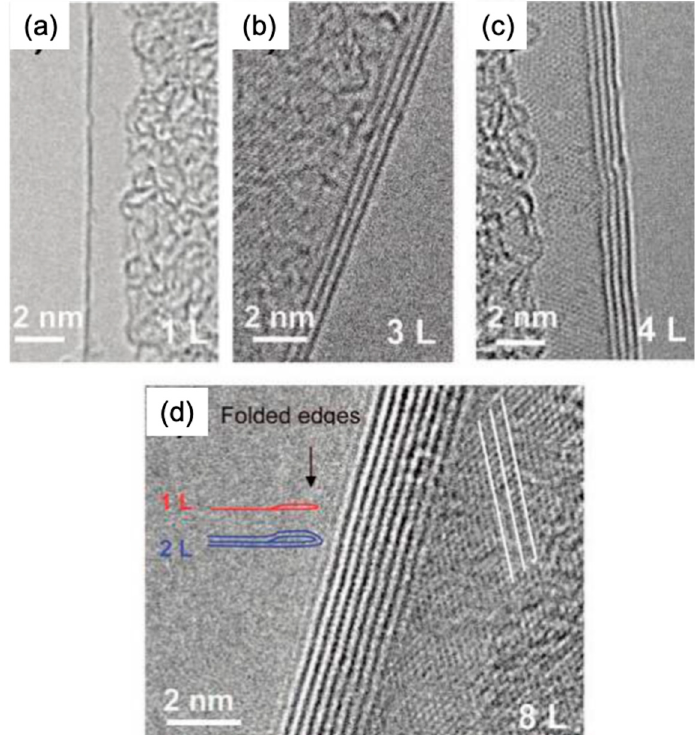
Figure 33. TEM images of CVD grown graphene showing different thicknesses, ( a ) 1 layer, ( b ) 3 layers, ( c ) 4 layers and ( d ) 8 layers. (reprinted with permission from [43]).